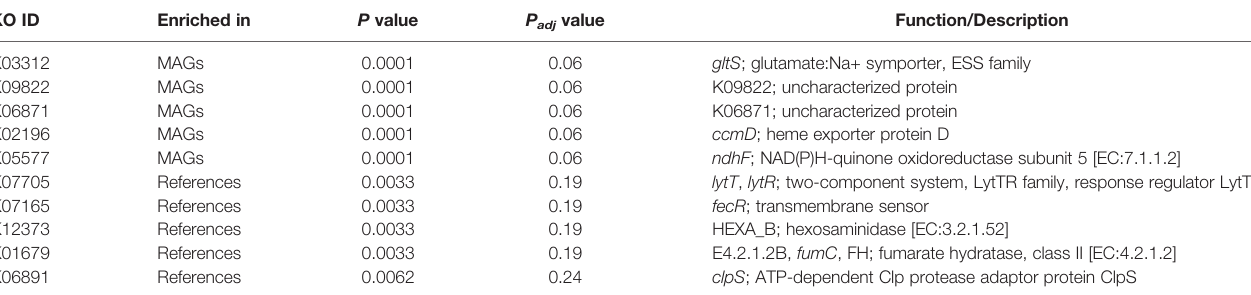
TABLE 1 | List of 10 most signi fi cantly enriched KOs in the Paucibacter MAGs and reference genomes. KO ID Enriched